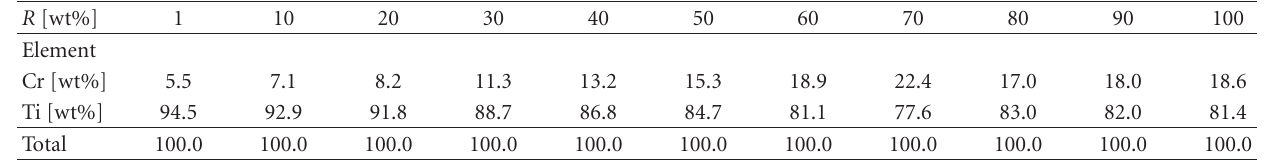
Figure 5: EPMA image of Cr-doped TiO 2 film prepared under the condition of R = 1wt%. Table 1: Relationship between each element and di ff erent R for Cr-doped TiO 2 film.